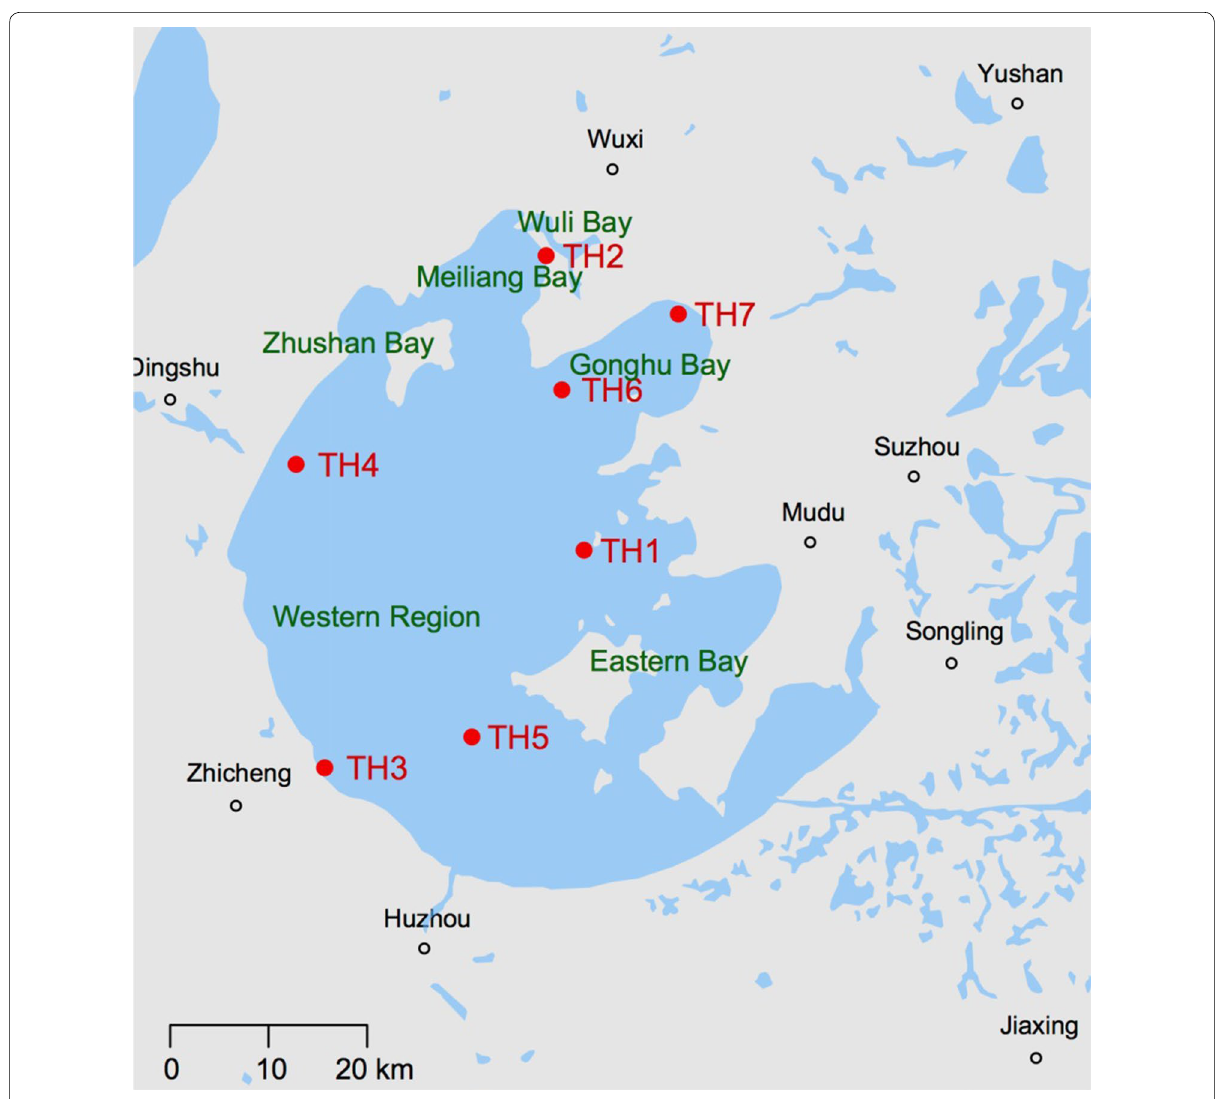
Fig. 1 Locations of seven sampling sites in Tai